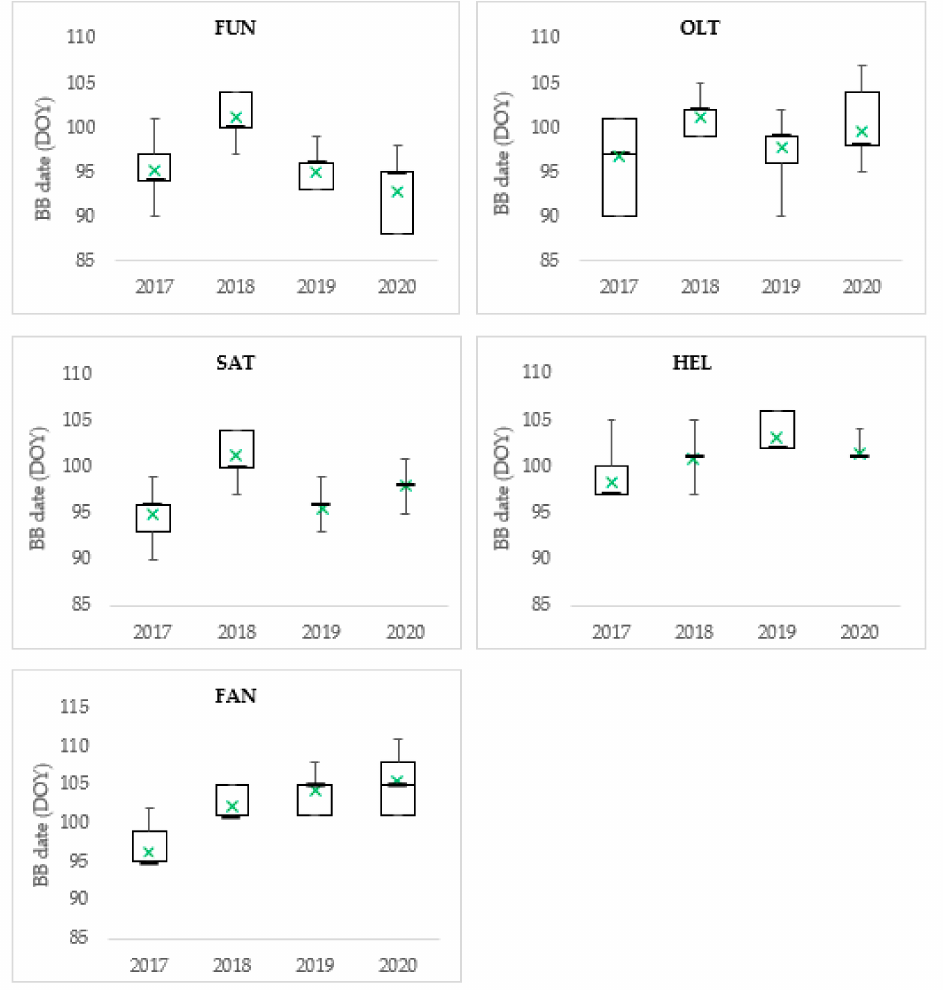
Figure 2. Boxplot diagram of sessile oak budburst phenophase in the studied populations. The bottoms and tops of boxes denote the 25 and 75% quartiles; the bold lines denote the median. The whiskers represent the minimum and the maximum DOY values. The green crosses indicate the mean value across all trees in each